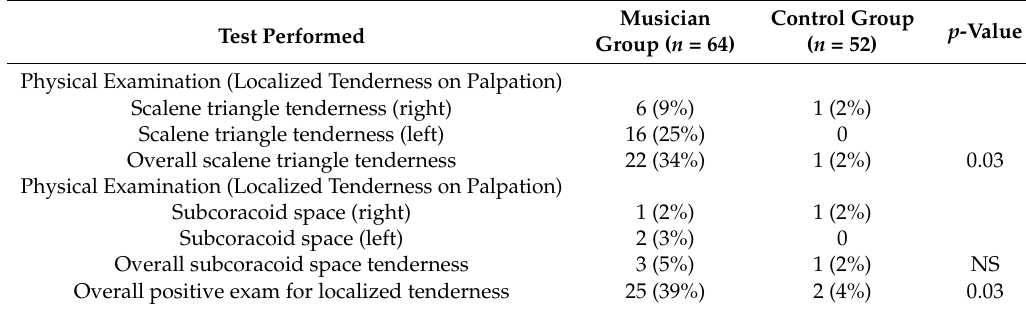
Table 2. Comparison of physical examination between the musician and control groups.